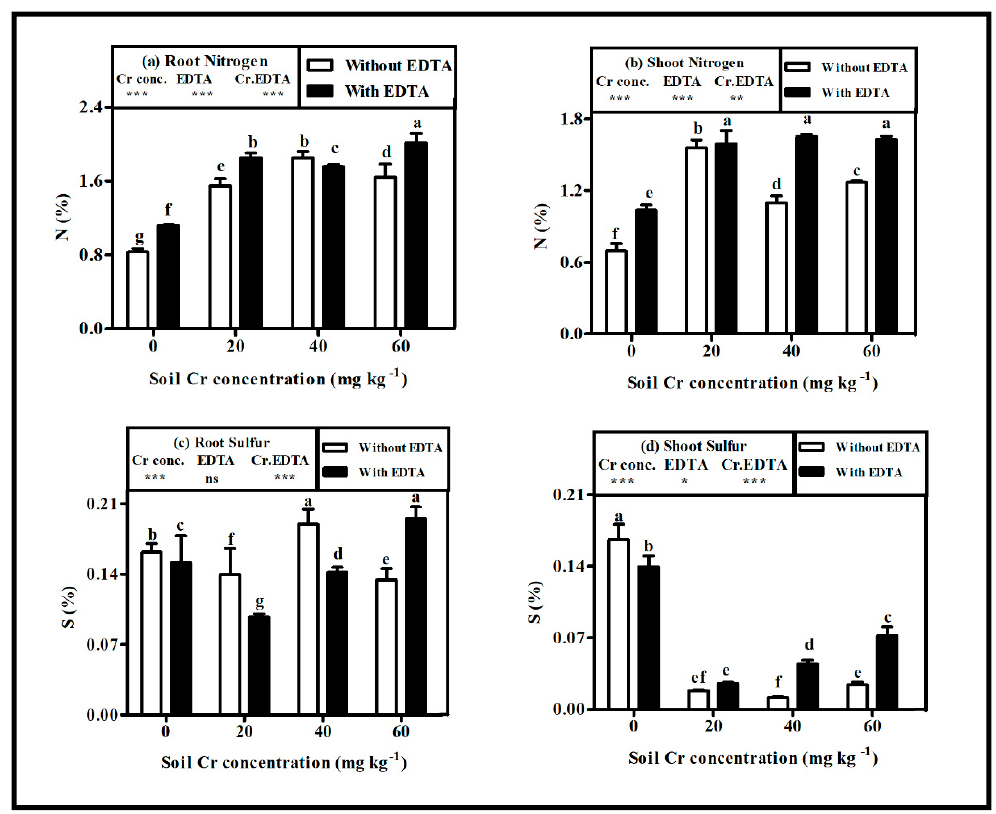
Figure 3. Influence of various Cr(VI) concentrations in soil on element levels (%) of ( a ) root nitrogen, ( b ) shoot nitrogen, ( c ) root sulfur, and ( d ) shoot sulfur of hybrid Napier grass with and without EDTA application. Bars with dissimilar letters are significantly different at p < 0.05 from Tukey’s test. Values are means ± SE, n = 5. * p < 0.05; ** p < 0.001; *** p ≤ 0.001. ns: non-significant, Cr conc.: soil Cr(VI)